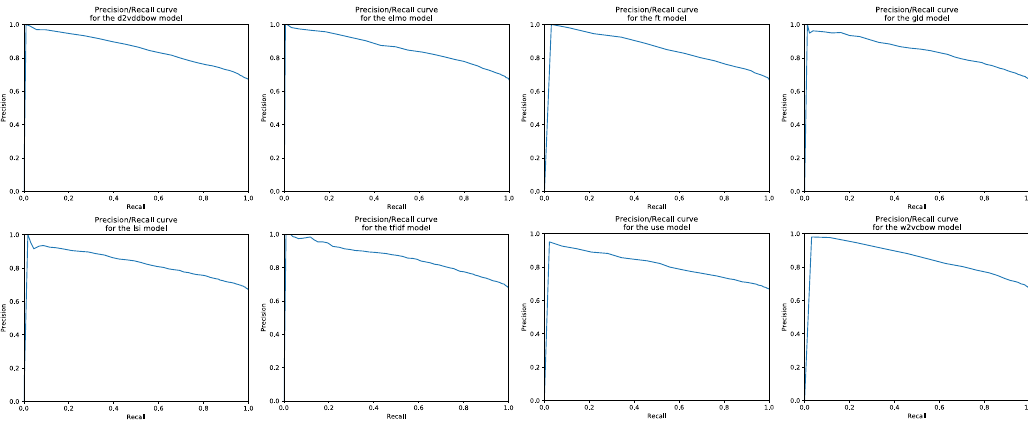
Figure A3. Precision/recall curves for eight models processing MSRP corpus.